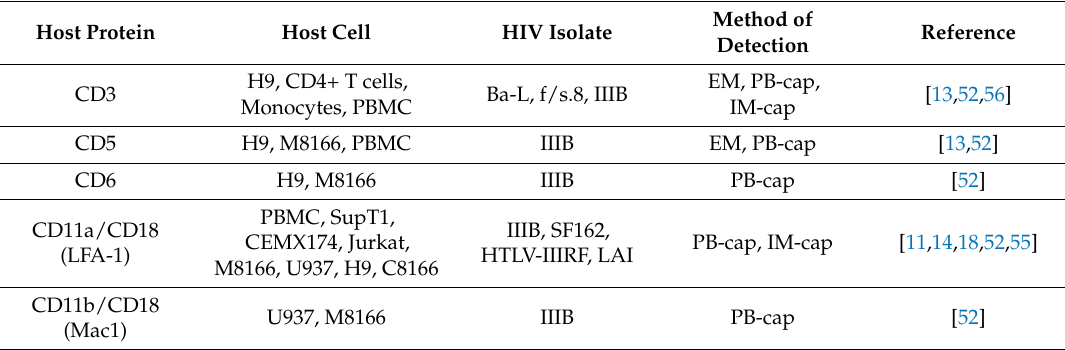
Table 1. Host proteins incorporated into the external HIV-1